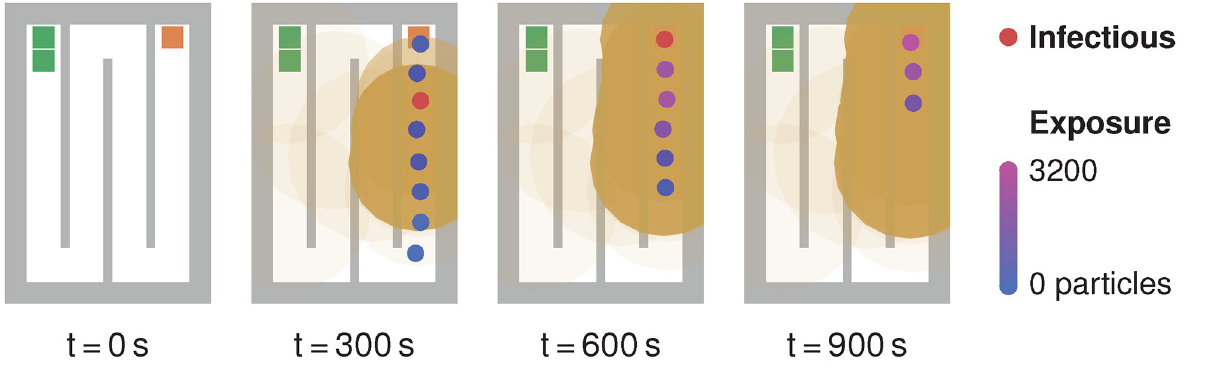
Fig 9. Queue scenario at different time steps. Susceptible persons (blue) are exposed to pathogens in aerosol clouds (orange circles) exhaled by an infectious person (red). The opacity of aerosol clouds reflects their current pathogen concentrations. The individuals’ colour indicates their degree of